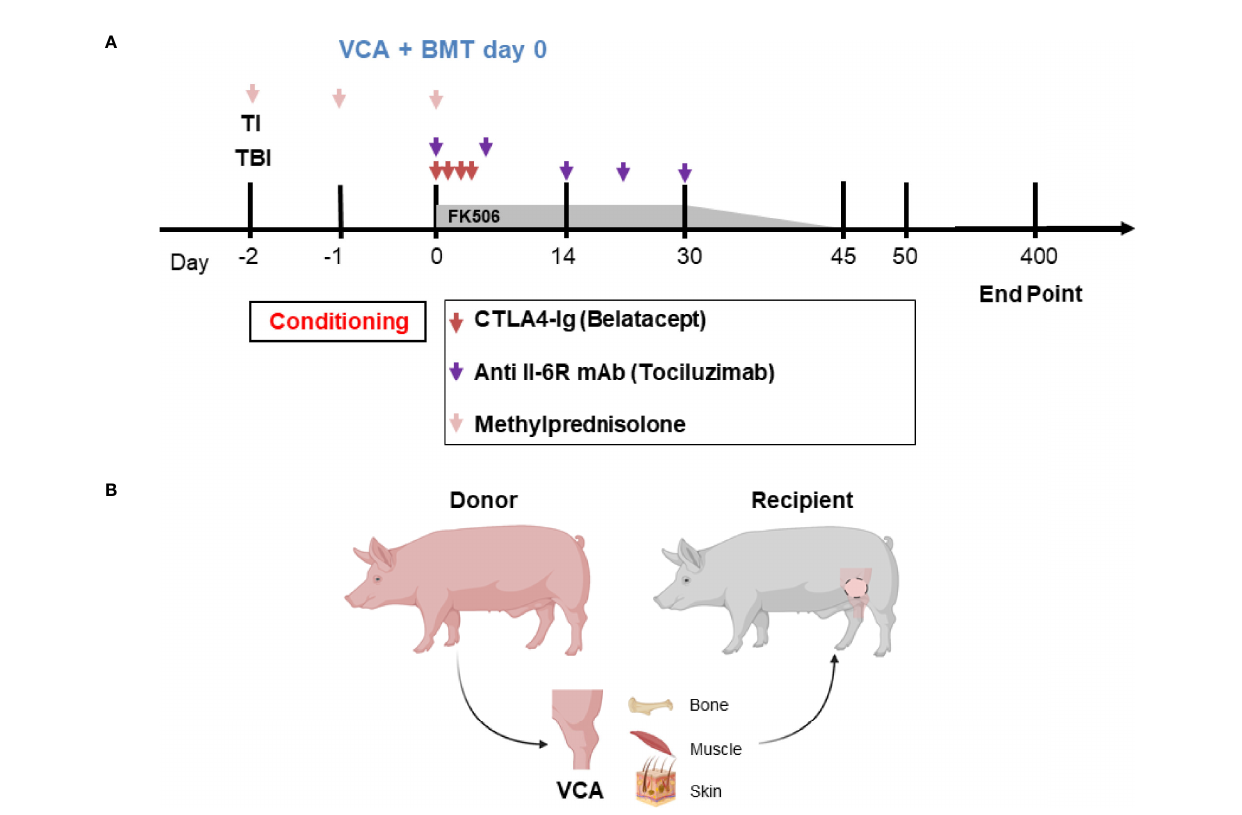
FIGURE 1 | (A) Mixed chimerism protocol for immune tolerance. Recipient conditioning begins prior to transplantation with total body irradiation (TBI, day -2) and thymic irradiation (TI, day -1). Induction is performed with methylprednisolone (days -2, -1, 0) and FK506. Following vascularized composite allotransplantation (VCA), the donor is exsanguinated, and bone marrow is harvested for transplantation (BMT) under the cover of CTLA4-Ig (Belatacept ® ) and anti-IL6R mAb (Tociluzimab ® ). FK506 is then continued for 30 days (target trough levels: 10-15 ng/mL) before gradual tapering to discontinuation on day 45; further CTLA4-Ig (Belatacept ® ) and anti-IL6R mAb (Tociluzimab ® ) is given I.V. 20 mg/kg (on POD 2, 4, 6) and I.V. 10 mg/kg (on POD 7, 14, 21, 28) respectively. (B) Schematic of donor hindlimb VCA tissue components and placement in the recipient. Image created with